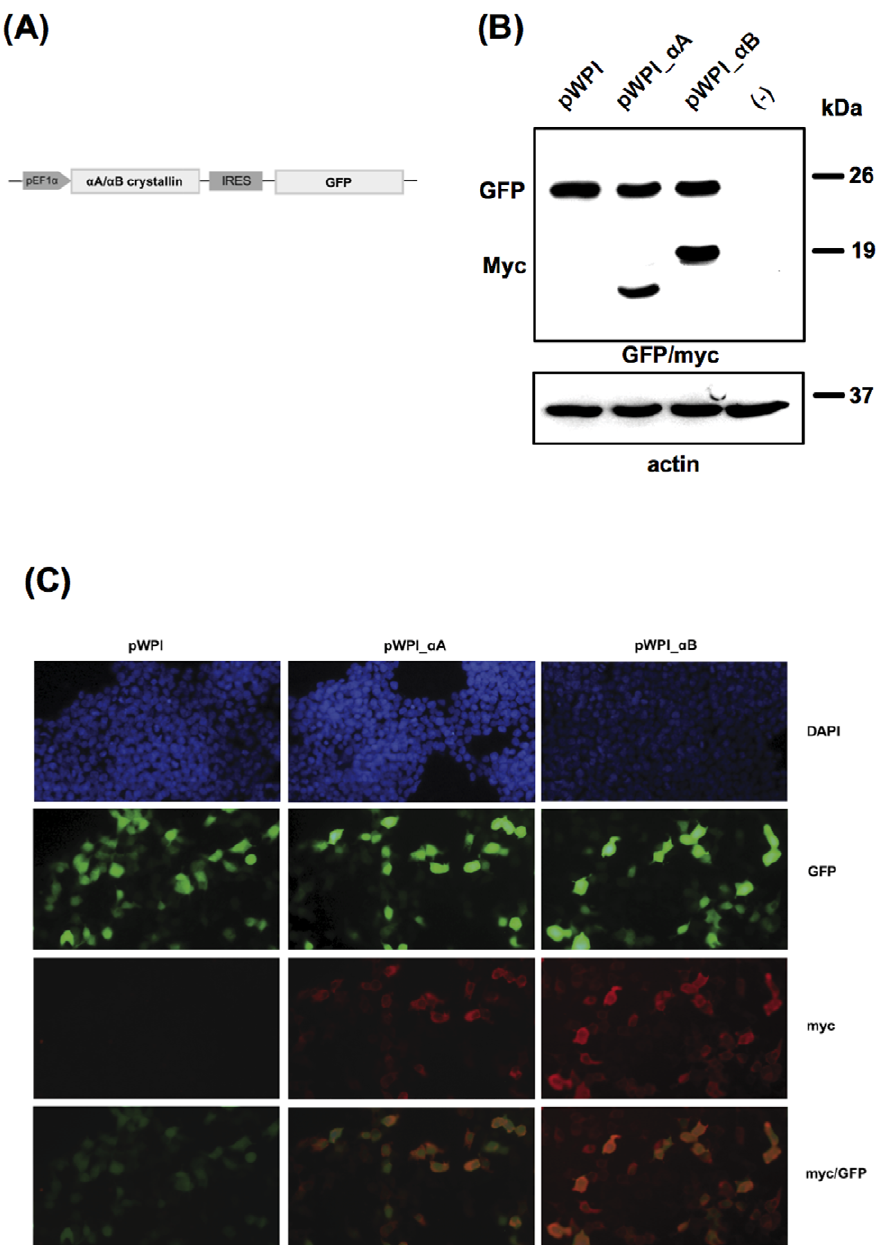
Figure 5. Stable expression of a -crystallins in 661W cells. ( A ) Schematic representation of the bicistronic pWPI lentiviral vector allowing for pEF1 a -driven simultaneous expression of the transgene ( a A- or a B-crystallin) and IRES-mediated GFP fluorescent marker. ( B ) Western blot analysis of a A- and a B-crystallins expressed in lentivirus-transduced 661W cells. Twenty-five micrograms of total proteins from cell extracts were subjected to 12% SDS-PAGE. Myc-tagged a A- and a B-crystallins were expressed in 661W cells transduced with the recombinant lentiviruses pWPI_ a A and pWPI_ a B, respectively, while no transgene was detected in cells transduced with the empty lentivirus pWPI or in non transduced cells ( 2 ). Membranes were further immunoassayed with anti-GFP as a control of transduction efficiency and with anti-ß-actin as a control of equal protein loading. ( C ) Immunofluorescence analysis with anti-myc showing cytoplasmic expression of a A- and a B-crystallins in 661W cells transduced with the corresponding recombinant lentiviruses. Cell nuclei were counterstained with DAPI and GFP staining was shown as a control of transduction efficiency. pEF1 a : EF1 a promoter; IRES: internal ribosome entry site from encephalomyocarditis virus.